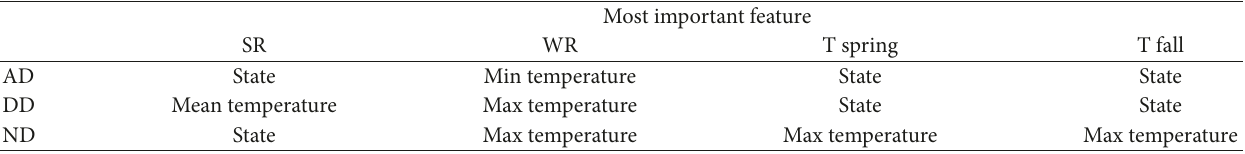
Table 3: Most influential feature impacting changing arrival dates, departure dates, and number of days for summer resident (SR), winter resident (WR), and transient (T) spring and fall